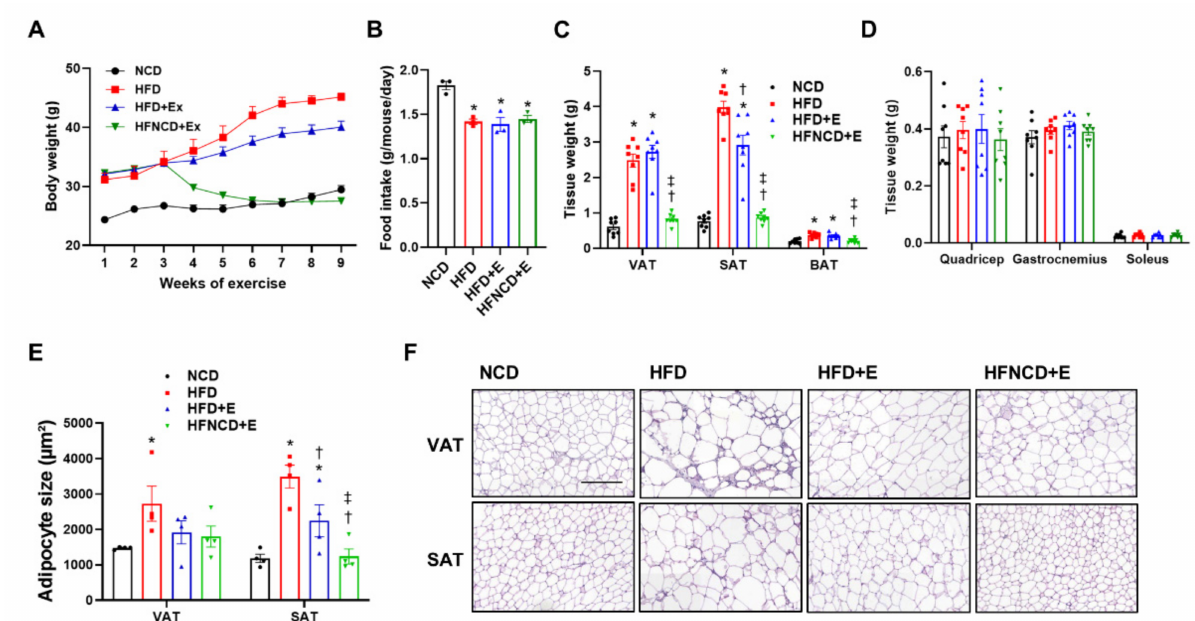
Figure 1. Exercise and diet attenuate weight gain and fat accumulation in HFD-induced obese mice. ( A ) Body weight change throughout the exercise intervention was measured. ( B ) Daily food intake was calculated per mouse on average for three weeks before sacrifice. ( C , D ) Tissues isolated after sacrifice were weighed. ( E , F ) H&E staining was performed for adipocyte morphology, and average adipocyte size was measured (scale bar indicates 200 µ m). Values are presented as mean ± SEM. * p < 0.05 compared with NCD, † p < 0.05 compared with HFD, ‡ p < 0.05 compared with